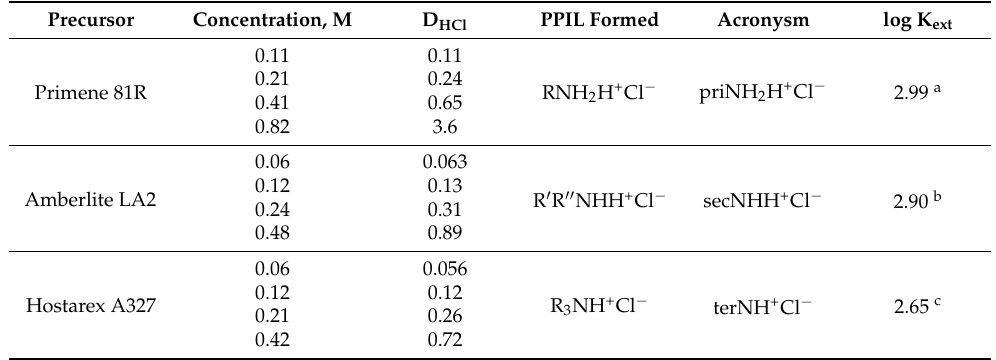
Table 1. Generation of the PPILs.